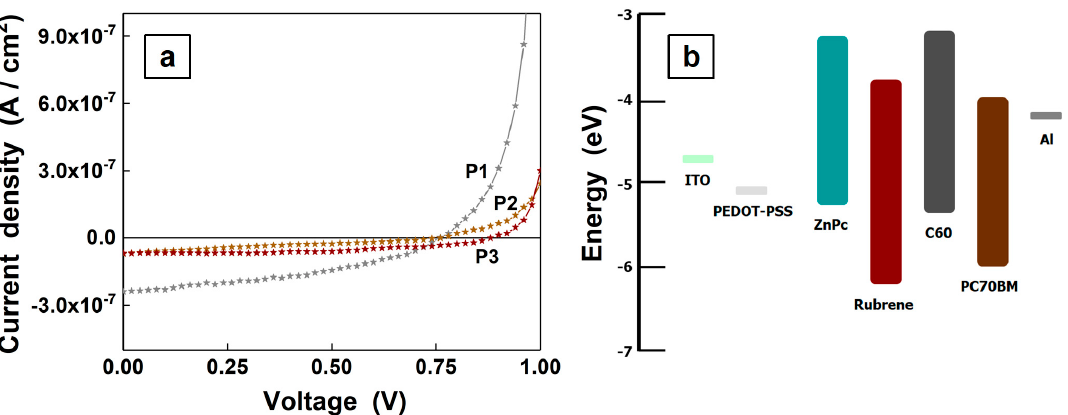
Figure 6. J-V characteristic of the structures based on MAPLE-deposited organic layers on ITO/PEDOT:PSS ( a ) and the energy level diagram of the materials integrated in these structures ( b ). Additionally, the values of the electrical parameters, short-circuit current density ( J SC ), open- circuit voltage ( V OC ), and maximum power ( P max ) corresponding to each investigated structure are